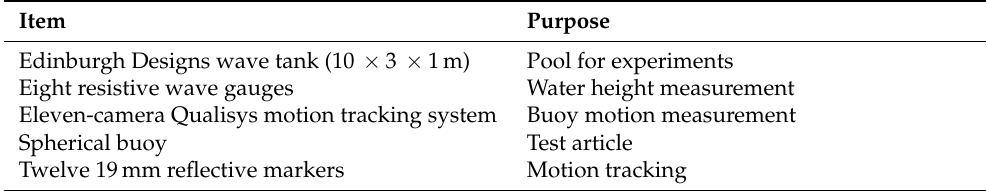
Table 1. Experimental apparatus